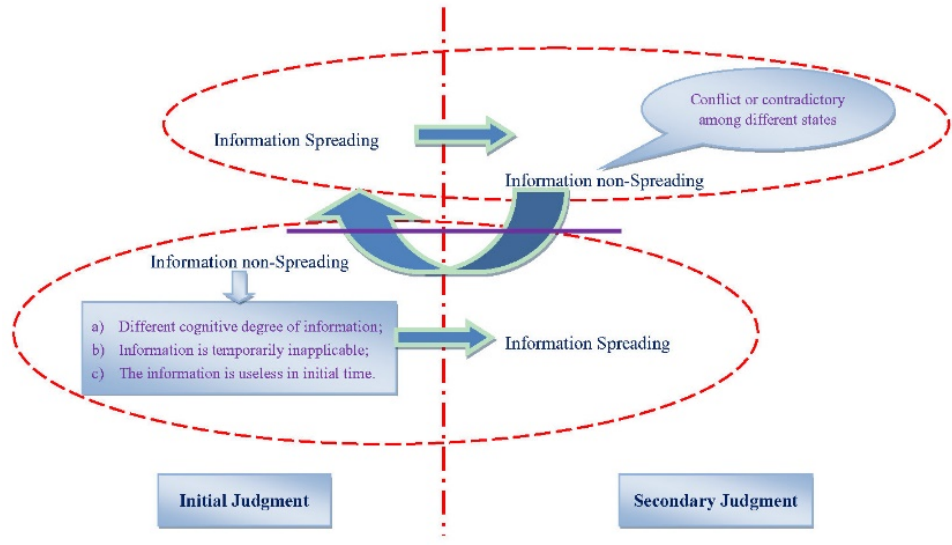
Figure 1. Information spreading under repeated judgment.